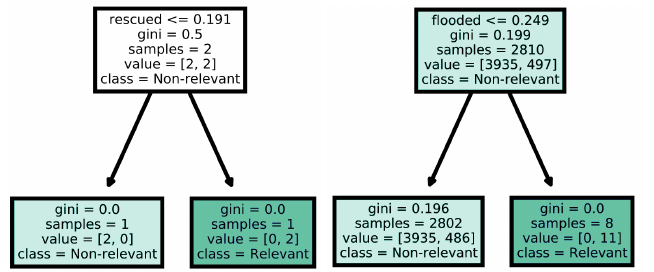
Figure 2. Two branches from one of the decision trees in the random forest model variant remove keywords